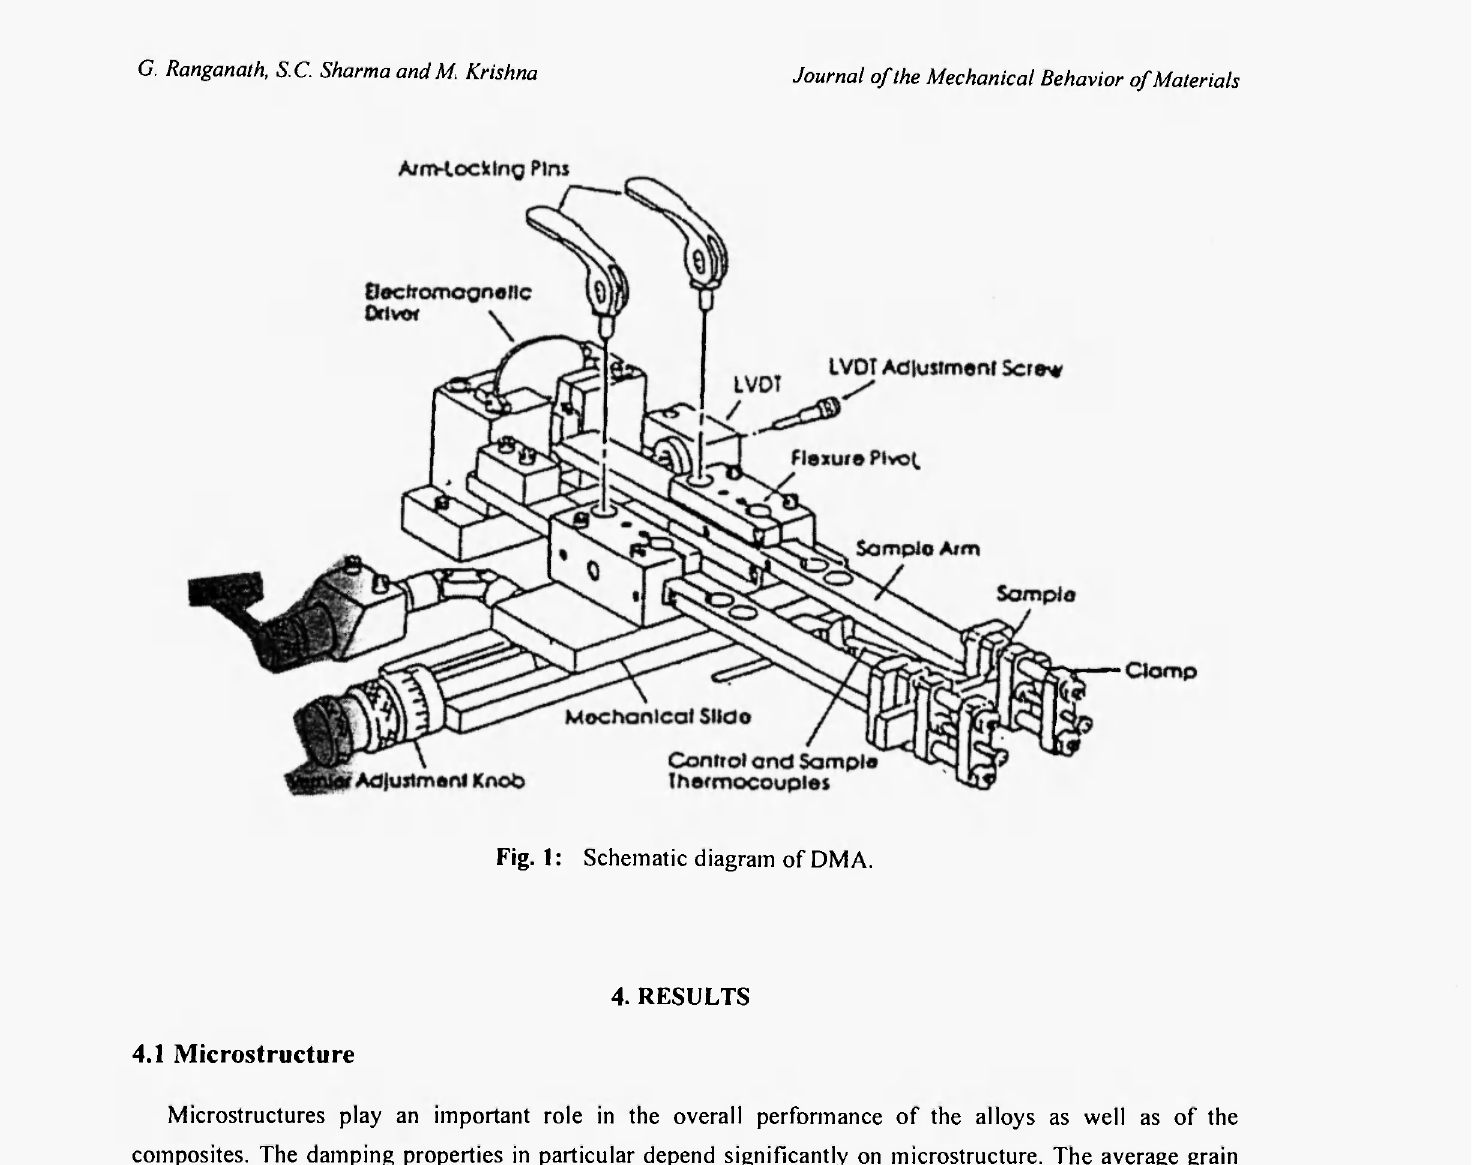
Fig. 1: Schematic diagram of